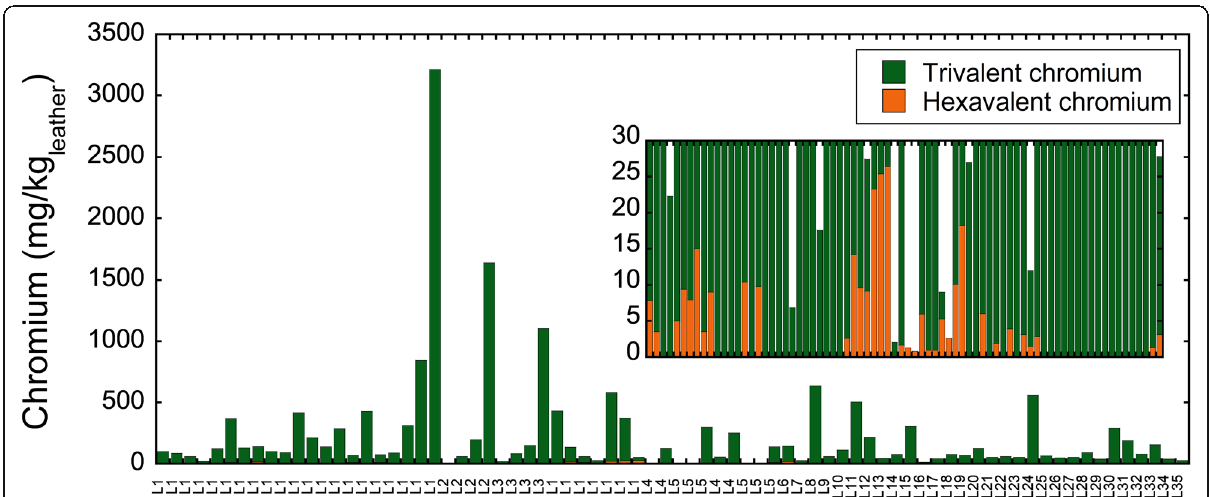
Fig. 1 Overview on some published data of the release of trivalent and hexavalent chromium from different leathers under different conditions. The inset shows a magnified graph. The same leather name, e.g. L1, indicates the same leather. All available information on the leather, pre- exposure, exposure conditions, and all data are given in Table S2 (supplementary